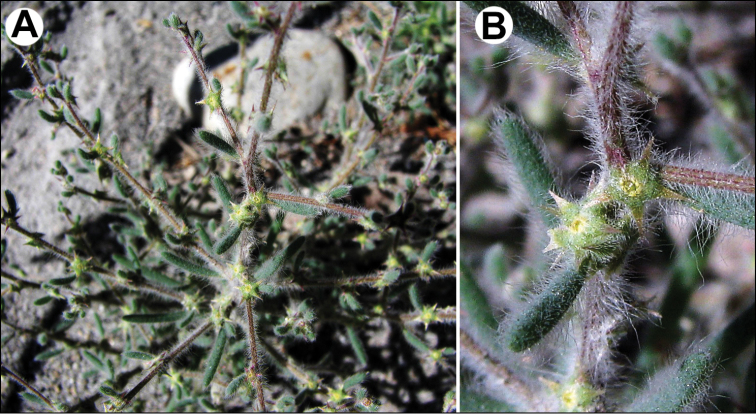
Gruboviadasyphylla: A general view of the plant at blooming stage B close-up of the flowers. Photographs by Prashant Awale (near Khalsar village, Nubra valley, Jammu & Kashmir, India, September 2011).